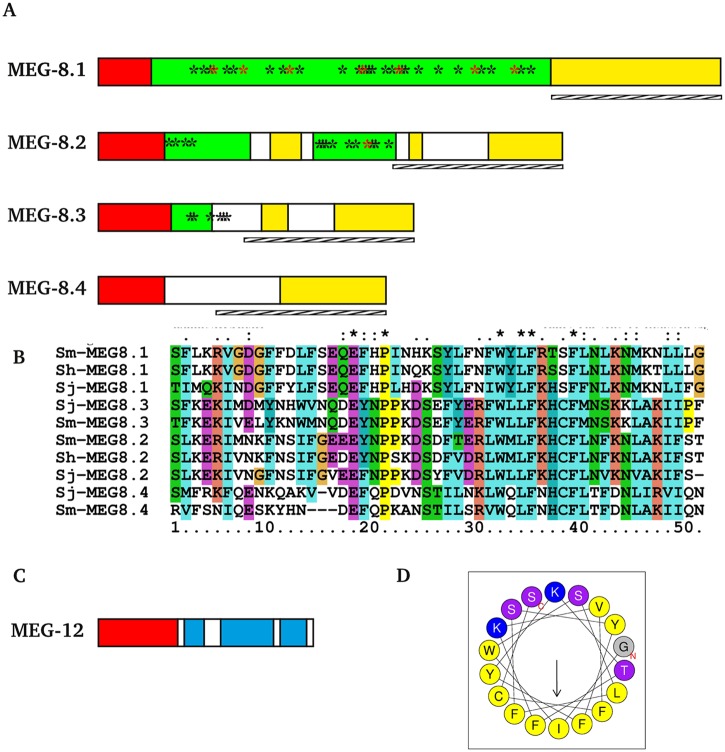
Bioinformatic analysis of MEG properties.
A) Schematic representation of protein products from MEG-8 family members. Bar represent the full coding sequence of each protein with colours representing different properties of each region: green, intrinsically unstructured hydrophilic region; red, signal peptide; yellow, hydrophobic region. Stars ind icate points of predicted O-glycosylation (black) or N-glycosylation (red). Hatched bar below each protein indicates the C-terminal conserved region. B) Multiple alignment of the conserved C-terminus of MEG-8 family proteins. C) Schematic representation of protein products from MEG-12 gene: pale blue, regions with predicted alpha-helical structure. D) Diagram of the central helix region of MEG-12 showing its amphipathic character. Colors indicate amino acids with: yellow, hydrophobic, purple, polar, blue, positively charged and small side chains. The hydrophobic face of the helix comprises the amino acids LFFIFF.